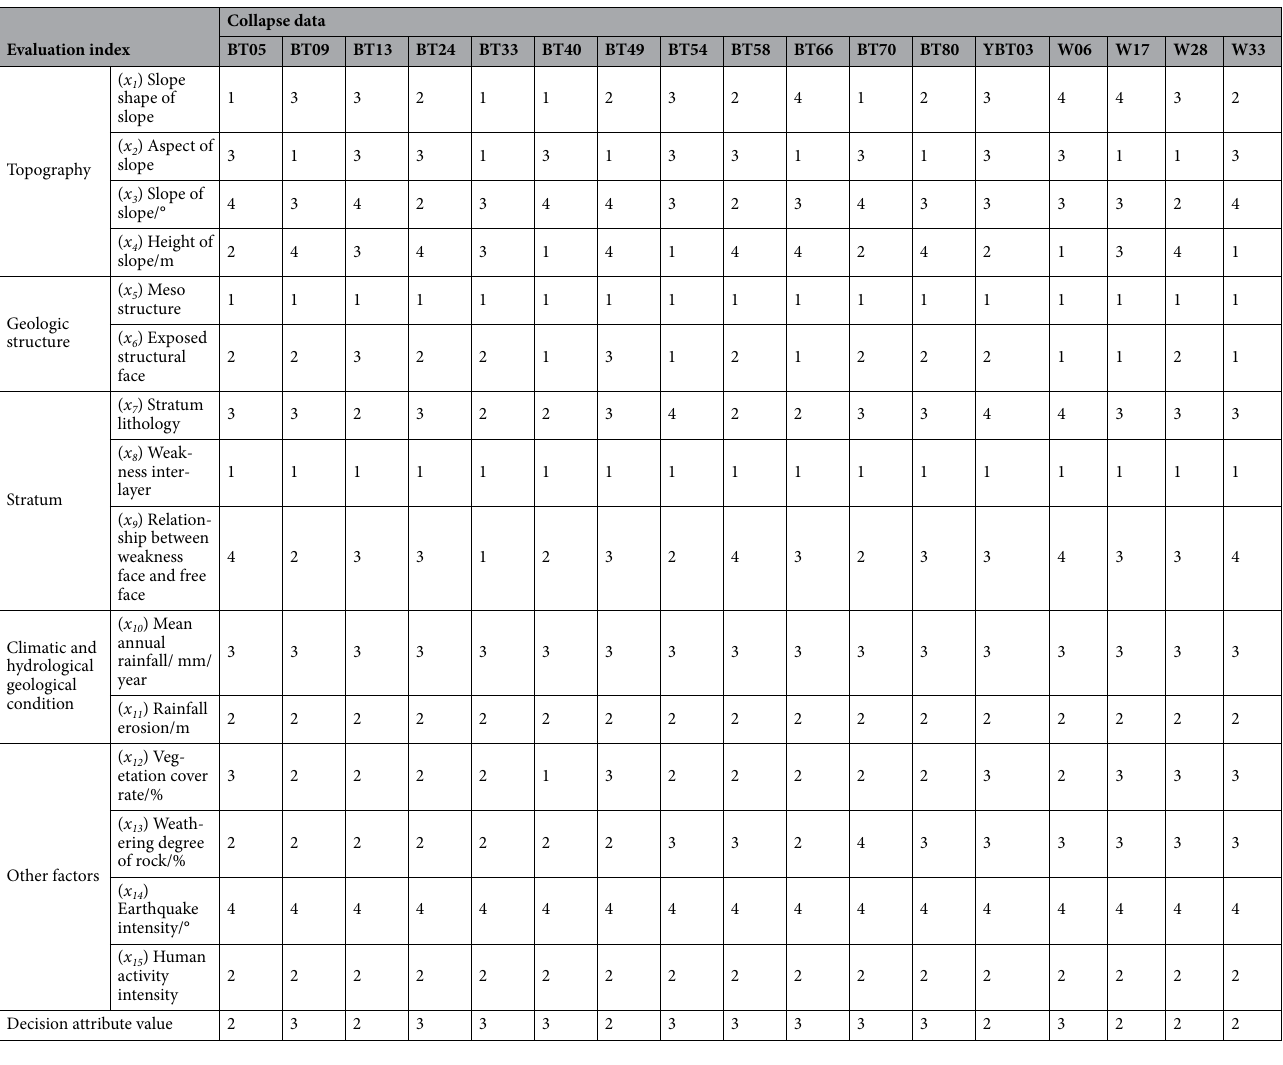
Table 2. Discrete evaluation data